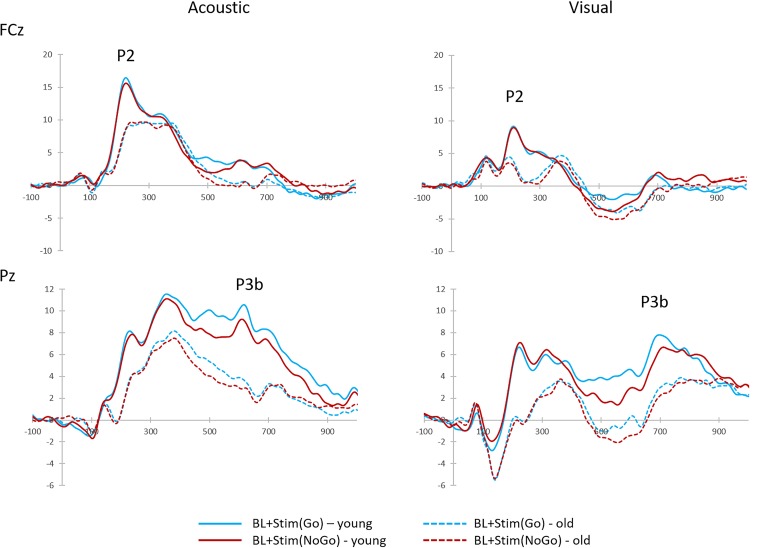
Grand-average target-locked P2 and P3b components to brake lights with secondary Go-stimulus [BL + Stim(Go)] and brake lights with secondary NoGo-stimulus [BL + Stim(NoGo)] in the discrimination task, shown at FCz (P2) and Pz (P3b), separately for acoustic and visual secondary stimuli.